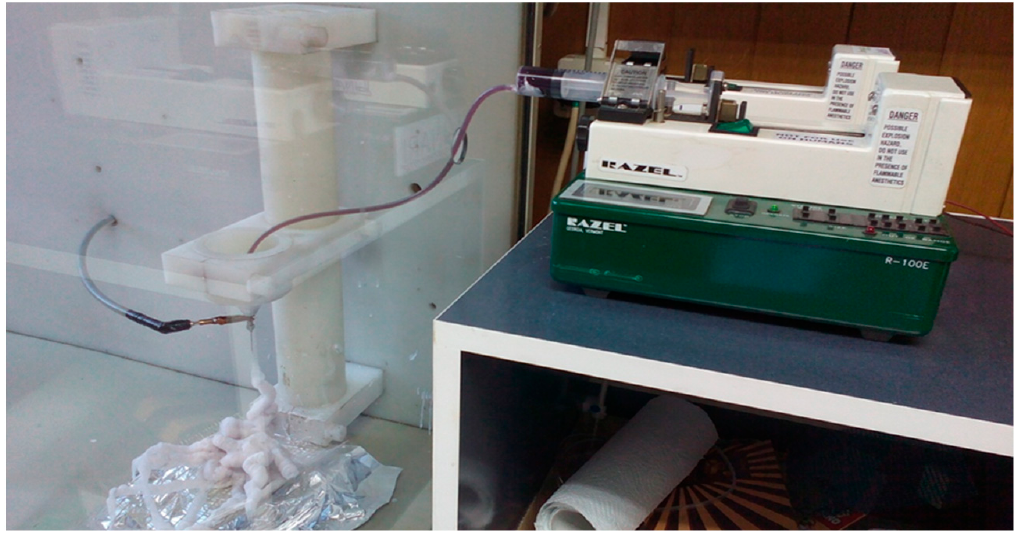
Figure 1. Setup for electrospinning of PS fibers.